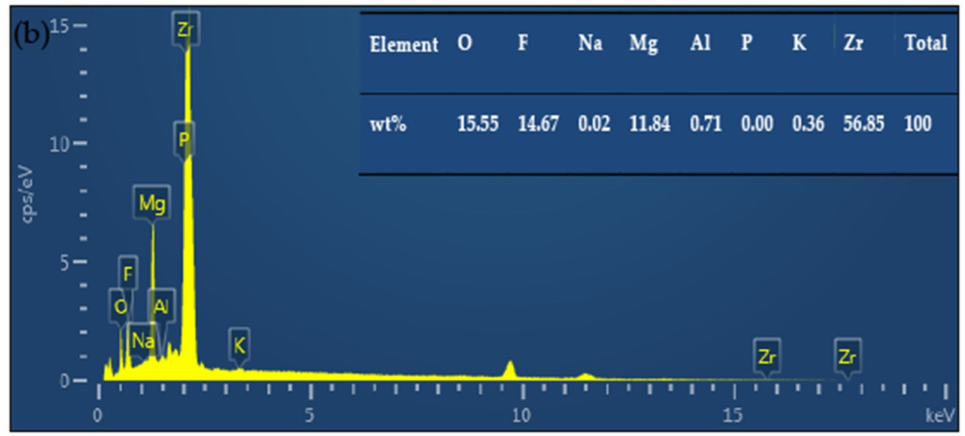
Figure 4. The elemental compositions of the ( a ) MgO coating and ( b ) ZrO 2 coating surfaces were analyzed using Energy dispersive spectrometer (EDS).